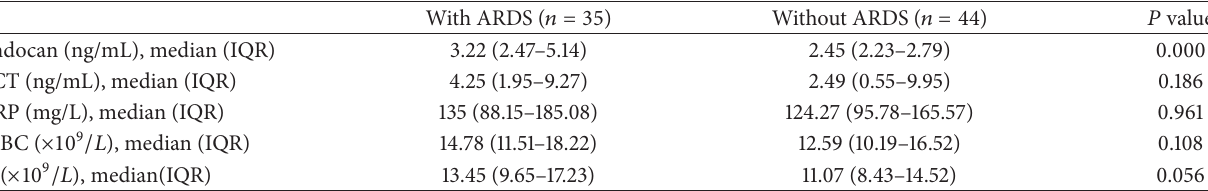
Table 7: Comparison of plasma biomarkers between pneumonia with ARDS and those without